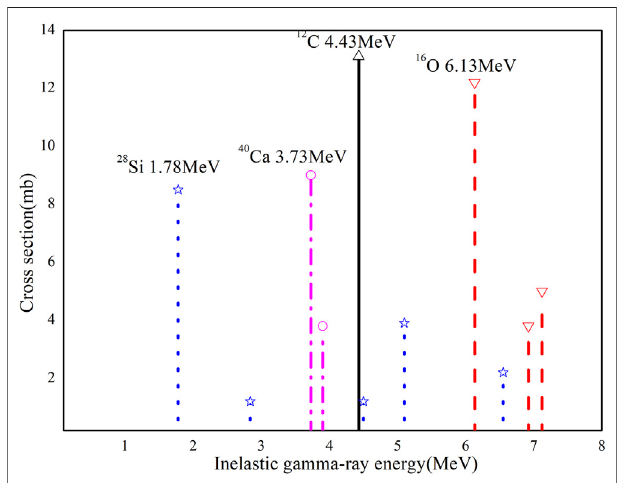
FIGURE 7 | Inelastic scattering gamma ray spectrum.